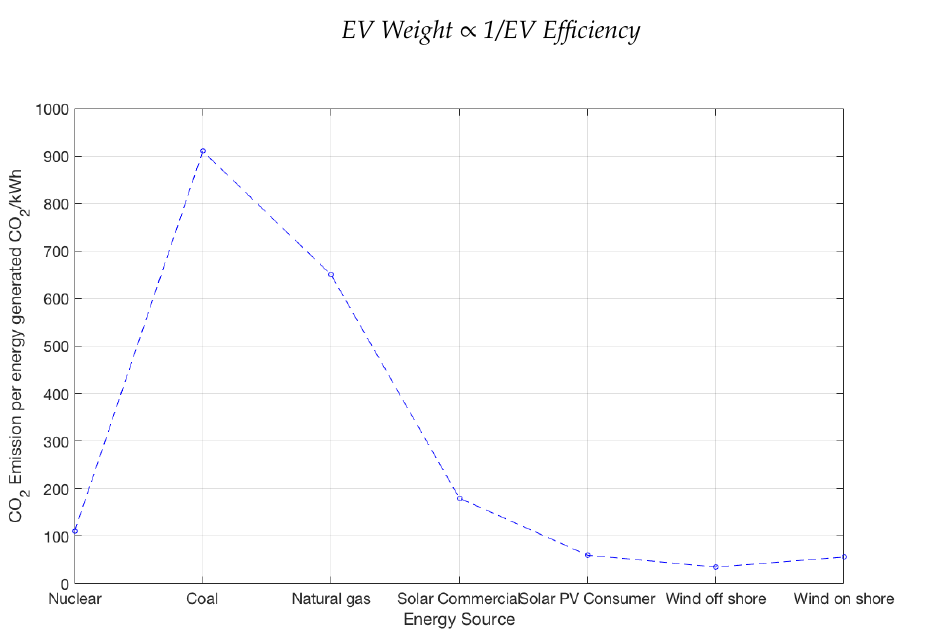
Figure 4. CO 2 /kWh generated from different energy sources.